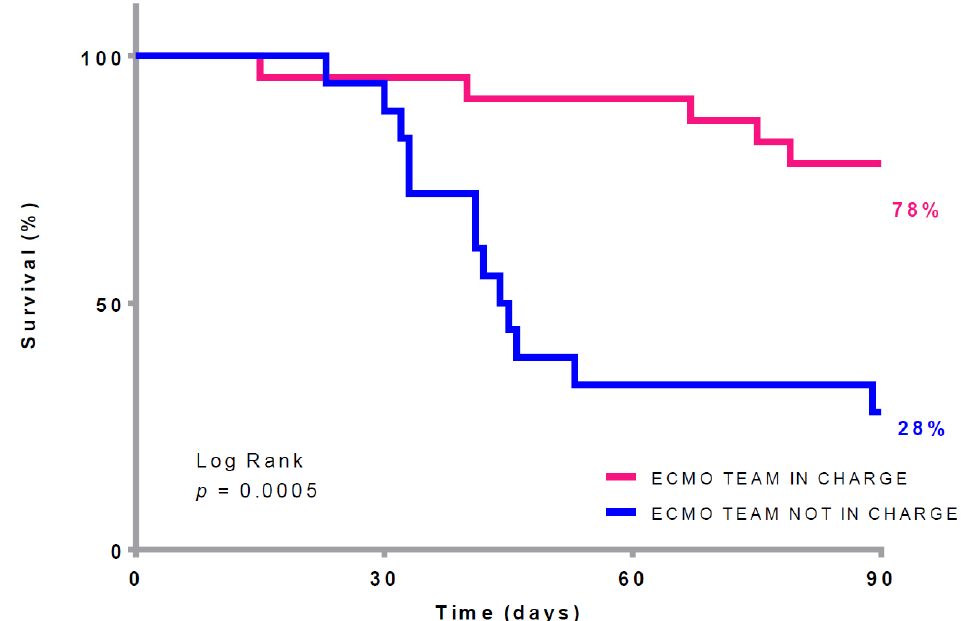
Figure 3. 90-day survival according ECMO patients managed or not managed by an experienced 261 and dedicated team. ECMO: extracorporeal membrane oxygenation. dedicated team. ECMO: extracorporeal membrane